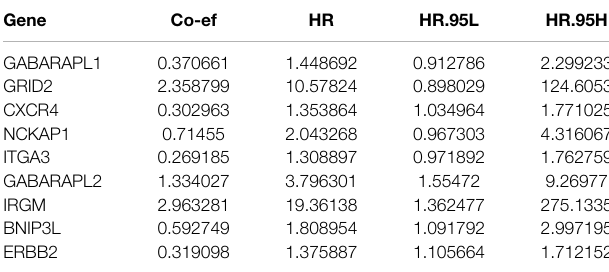
TABLE 2 | Multivariate Cox regression analysis of prognostic genes.